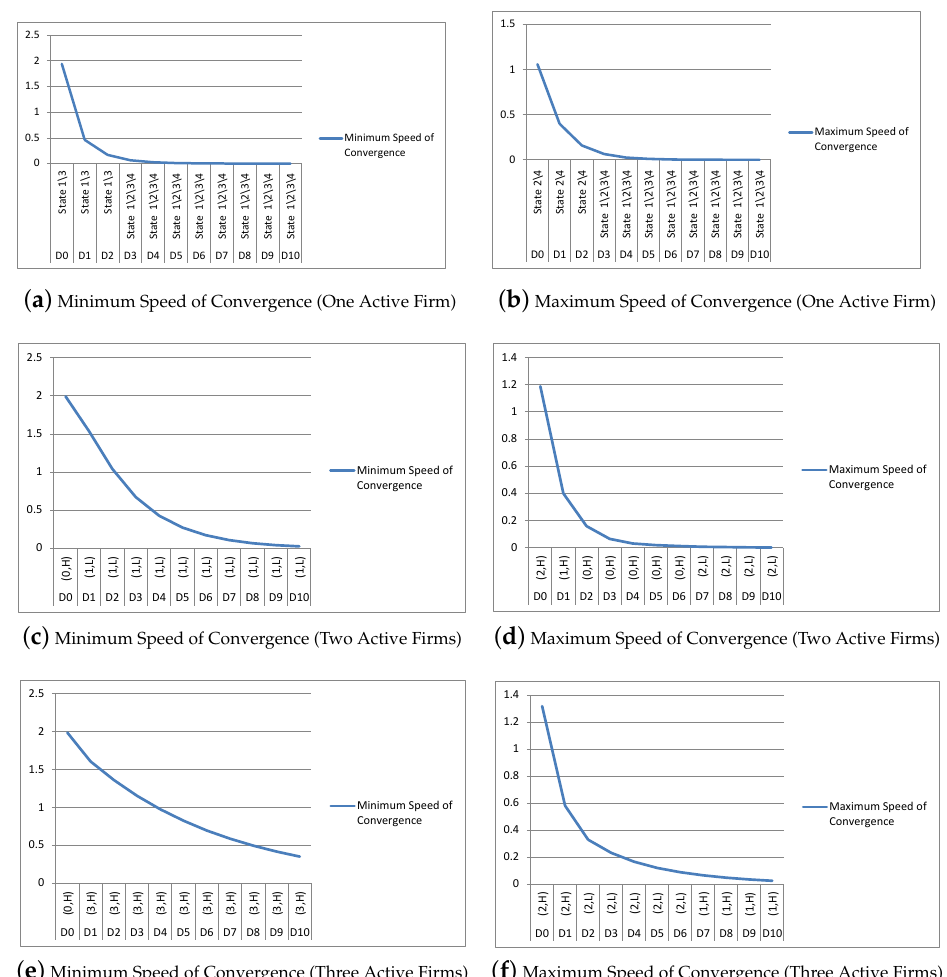
Figure 1. The speed of convergence in the Cournot